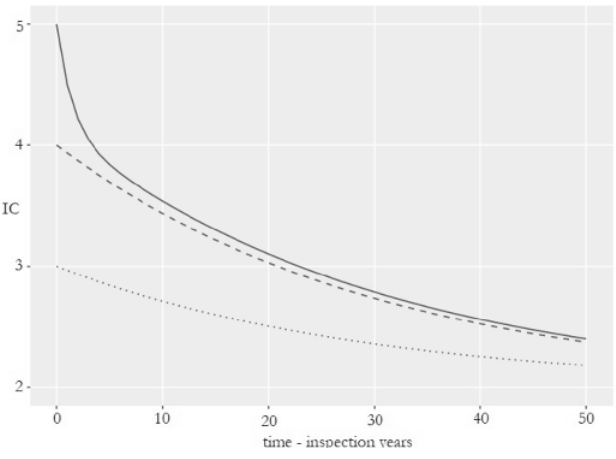
Deterioration model of Fernão Dias Road bridges – General